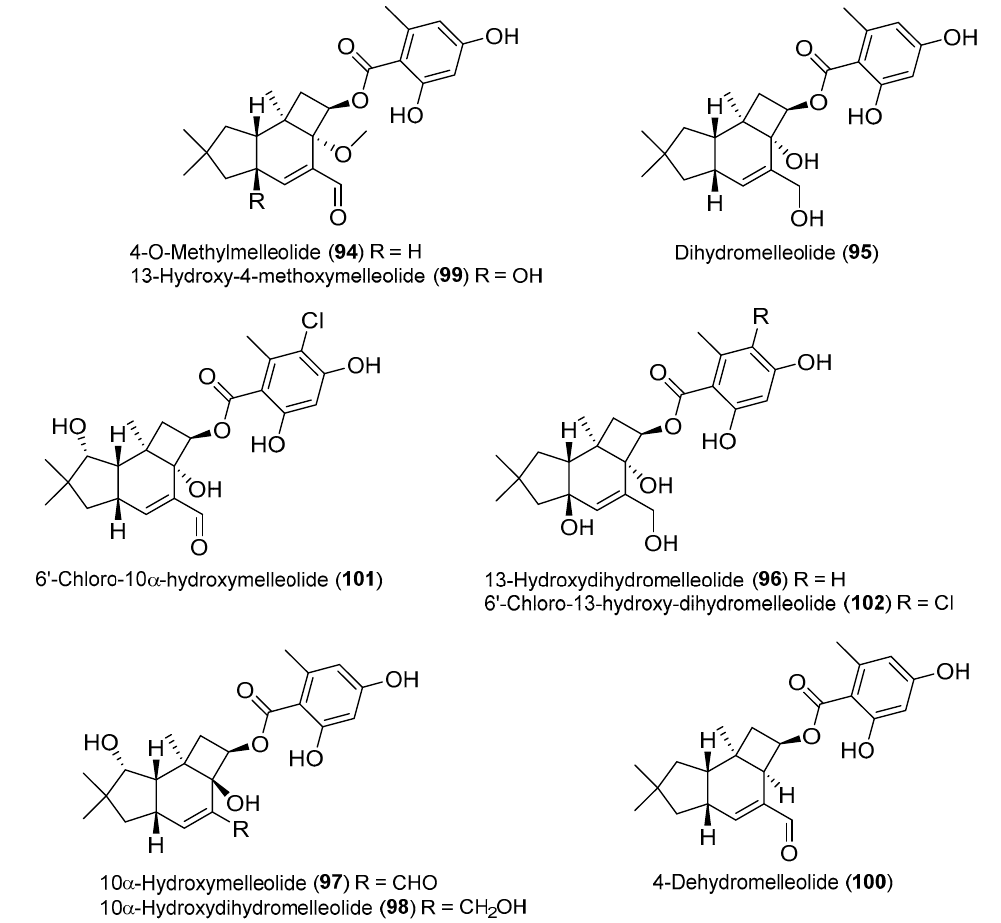
Figure 16. Structures of melleolides 94 – 102 isolated from Armillaria mellea.